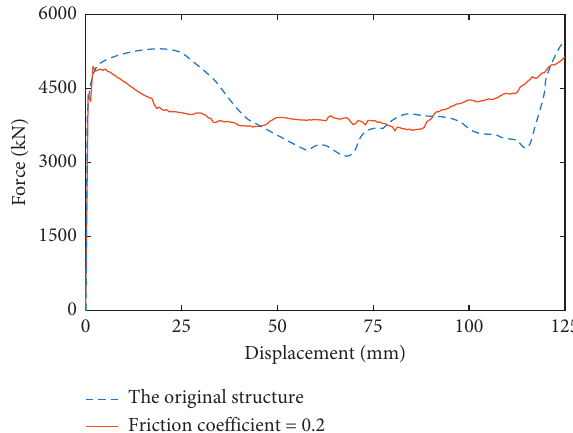
Figure 16: Comparison of the load-displacement curve between a friction coefficient of 0.2 and the original structure.